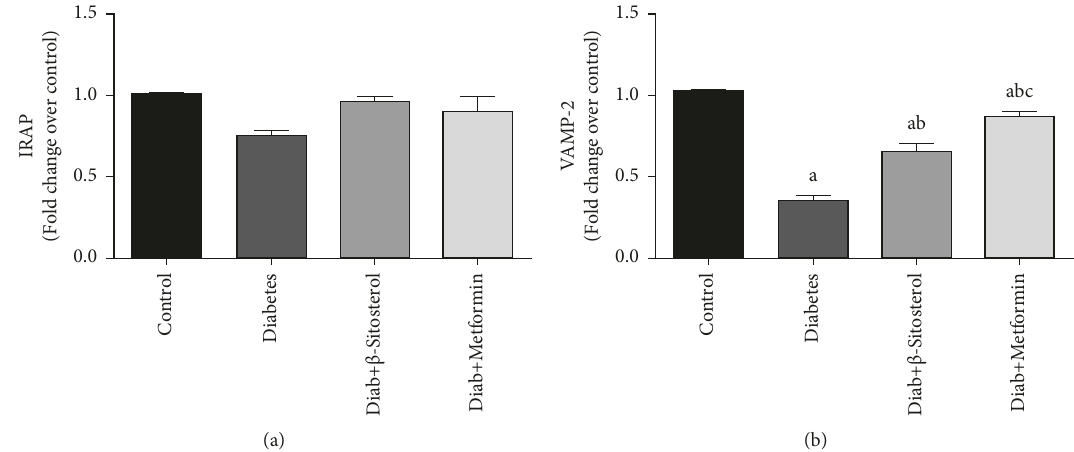
Figure 6: (a and b). Effect of β -sitosterol on expression levels of IRAP and VAMP-2 in HFD and sucrose-induced diabetic adult male rats was measured by real-time PCR. Mean ± SEM of 6 animals was represented in each bar. The values, which are statistically significant ( p < 0 . 05), were compared with a—control, b—diabetic control, and c— β -sitosterol-treated diabetic group. Data showed that IRAP mRNA expression has no significance difference between the groups. (a) IRAP mRNA. (b) VAMP-2